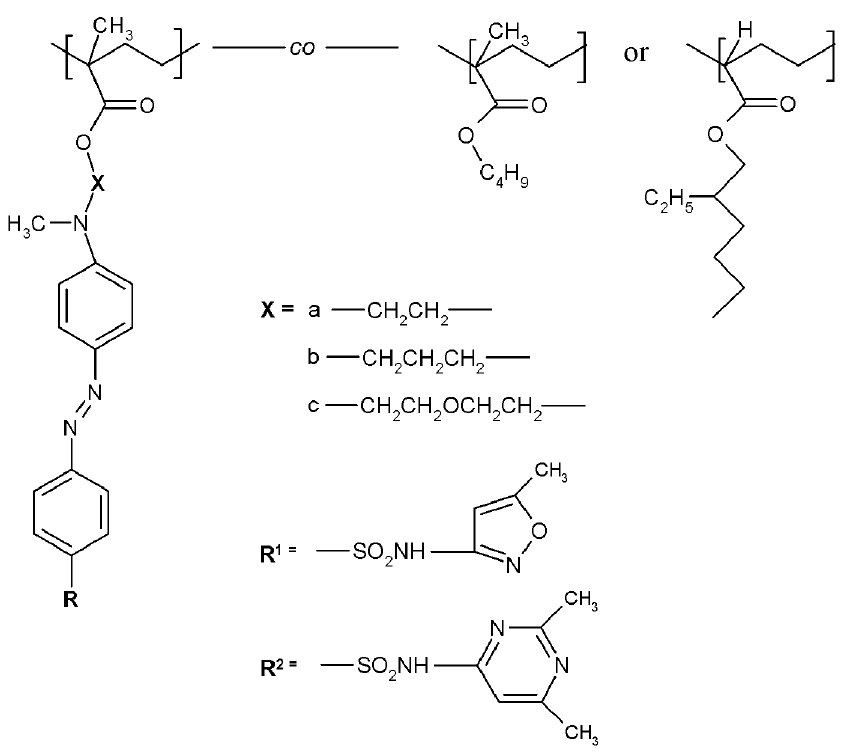
Fig. 2 Structural formulae of